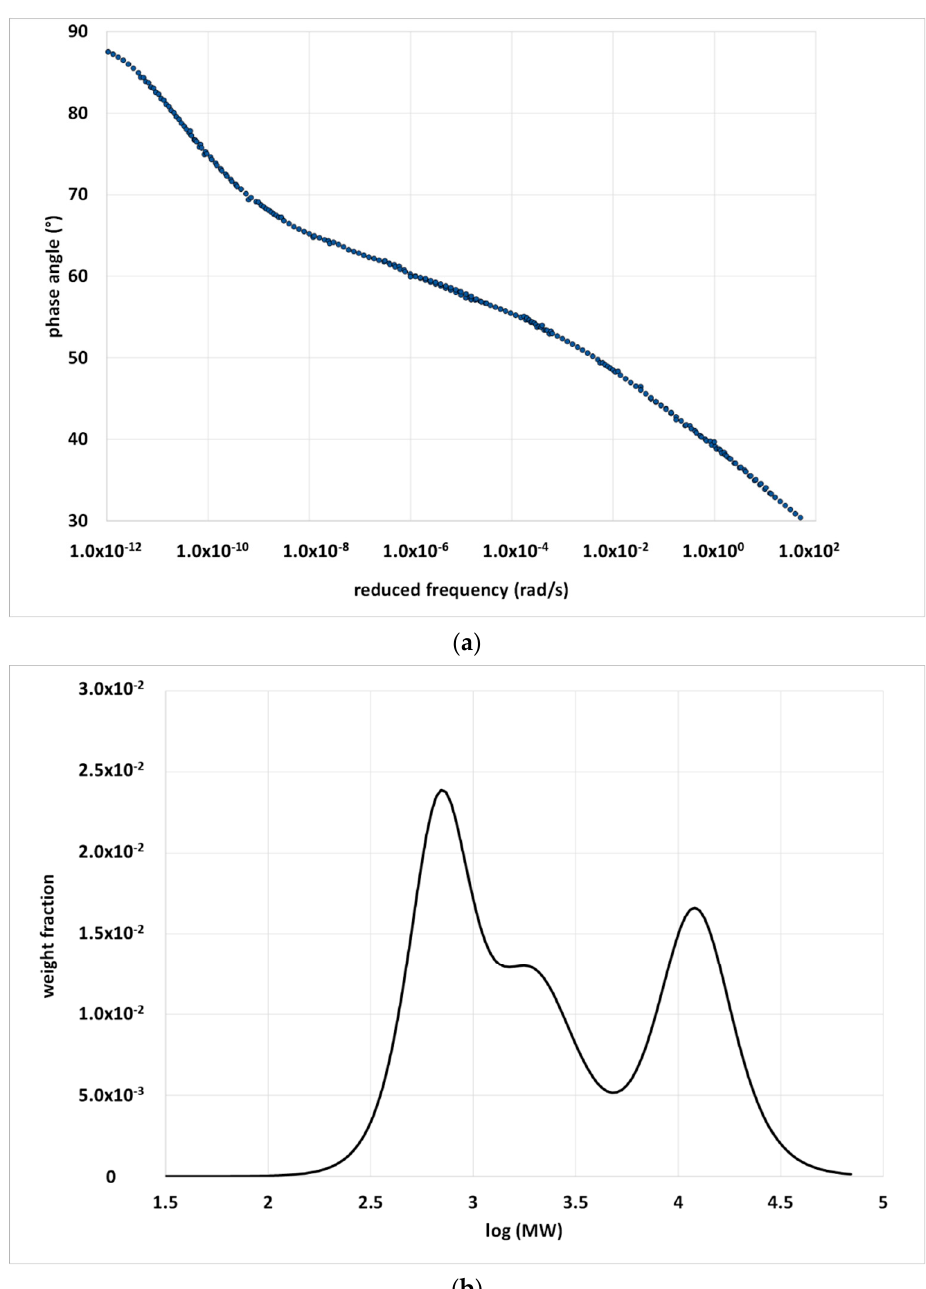
Figure 11. ( a ) Phase-angle master curve of a PMB containing 5% SBS. ( b ) BMWD obtained from the master curve reported in ( a ). Details are given in [32].